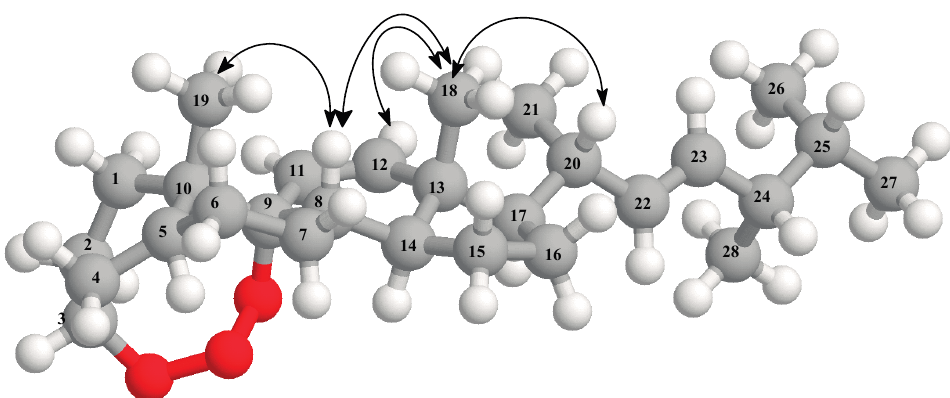
Figure 2. Select (NOE) spatial correlations and relative stereochemistry for